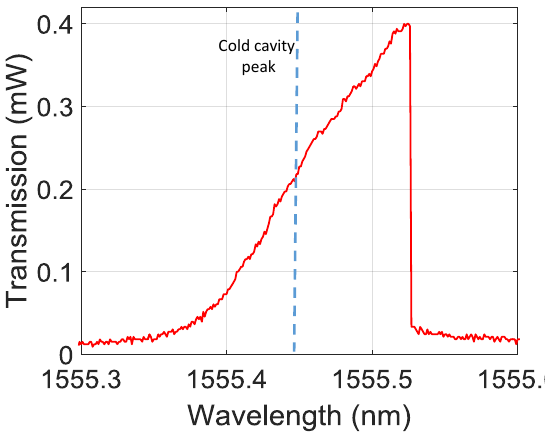
Figure 1. Measured transmission spectrum of a silicon π -phase shifted grating demonstrating resonantly enhanced thermal refractive index detuning